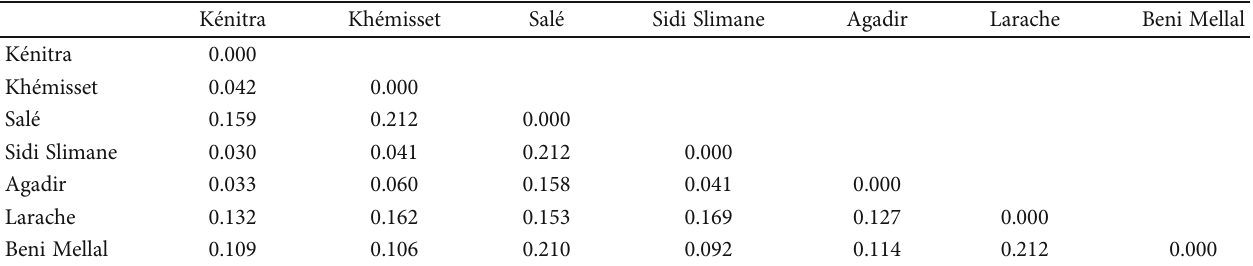
Table 6: Pairwise population matrix of Nei genetic distance.